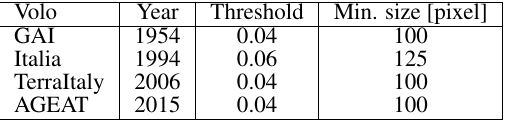
Table 4. Optimal segmentation parameters for ortho-photos datasets.